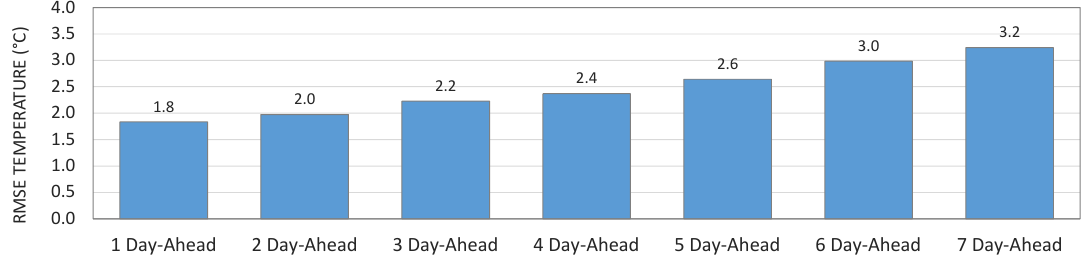
Figure 6. The temperature RMSE between Observation and Dark Sky forecasts from 1-day to 7-day (from 12 February 2018 to 22 April 2018).